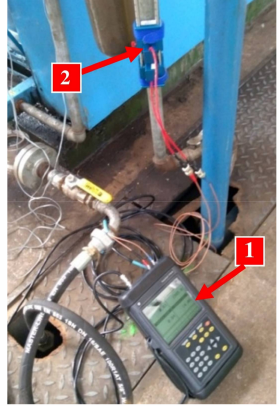
Figure 3. Connection of the flow meter at the cooling water inlet pipe (1—GE Transport PT878, 2—UTX DR measuring probe).